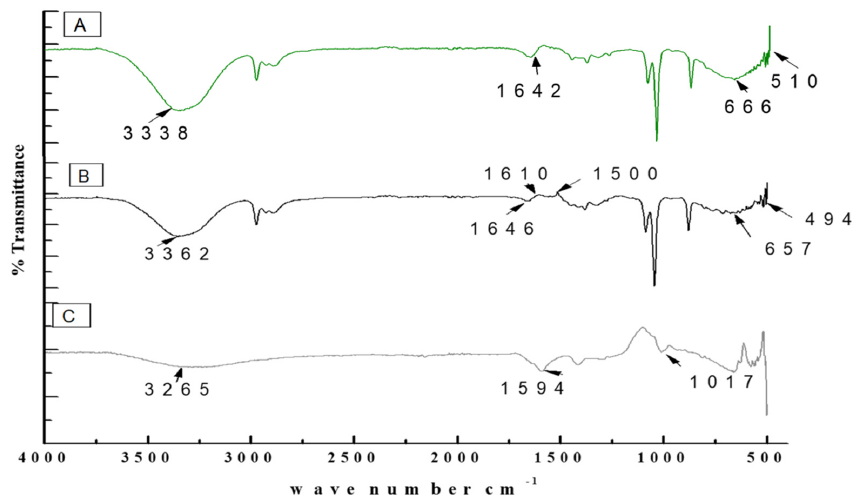
Figure 9. FTIR spectrums of ( A ) TiO 2 nanoparticles, ( B ) CI-TiO 2 -MS, and ( C ) blank MS. Table 1. Peak values and functional group vibrational modes obtained from microspheres and TiO 2 nanoparticles.